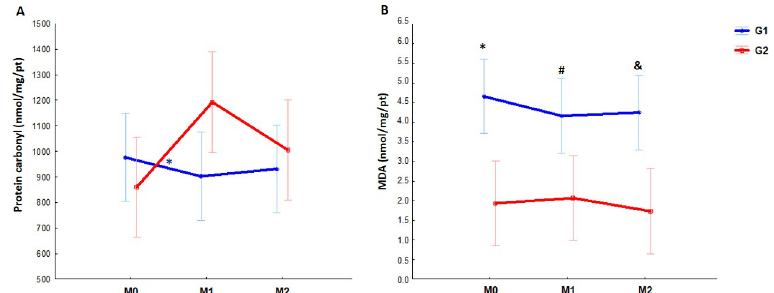
Fig 2. Longitudinal evaluation of oxidants markers (protein carbonyl and malondihaldeide [MDA]) from 23 pregnant women infected and not infected by HIV. Bars: 95% confidence interval. M0: moment zero (first or second trimesters), M1: moment one (third trimester), M2: moment two (post-partum). G1 (red): HIV-positive women, G2 (blue): HIV-negative women. A ; � blue: difference between M0 and M1(p = 0.01). B ; G1 × G2: � black: M0 p < 0.0001, # black: M1 p = 0.0005 and & black M2 p < 0.0001. Statistical analysis: Gamma Distribution. followed by Tukey-Kramer post hoc tests (SOD) and Gamma Distribution (CAT).